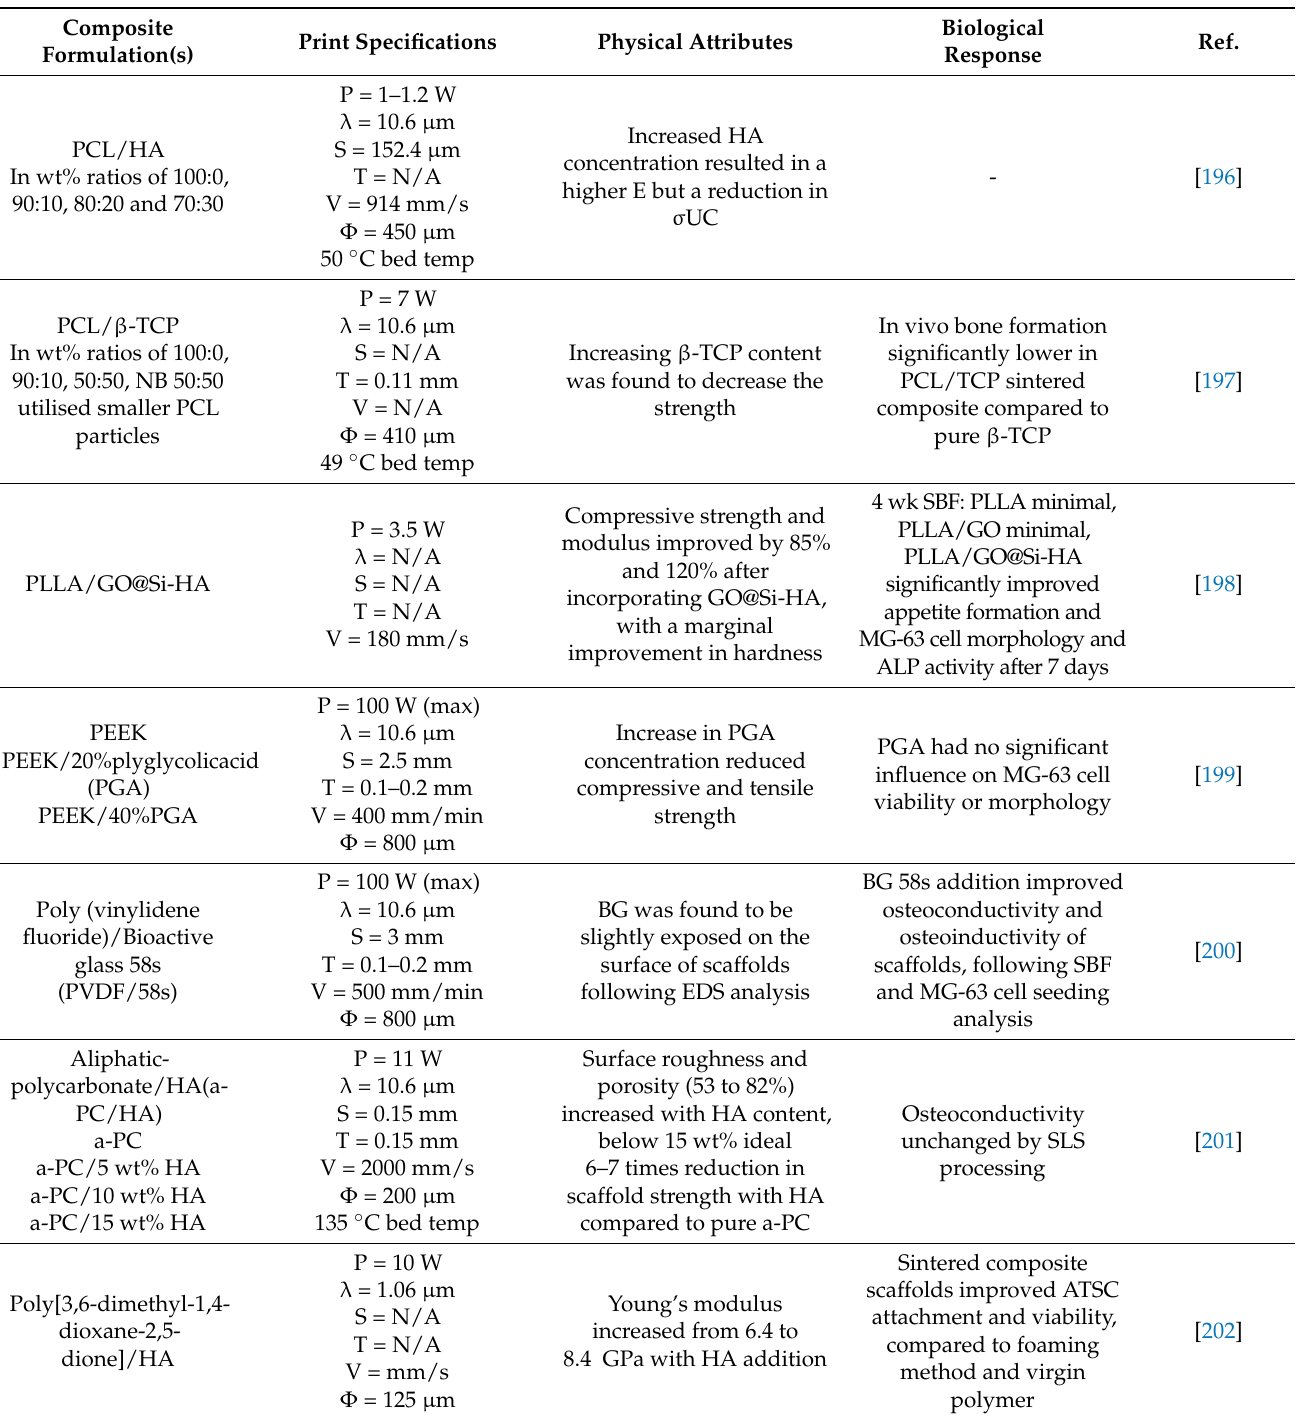
Table 1. Summary of composite sintering approaches outlining the specific print parameters utilised, physical attributes, and biological outcomes of the printed constructs. Where P = Laser Power, λ = Wavelength, S = Scan Spacing, T = Layer thickness, V = Scan Velocity, Φ = Beam Diameter, E = Elastic Modulus, σ UC = Ultimate Compressive